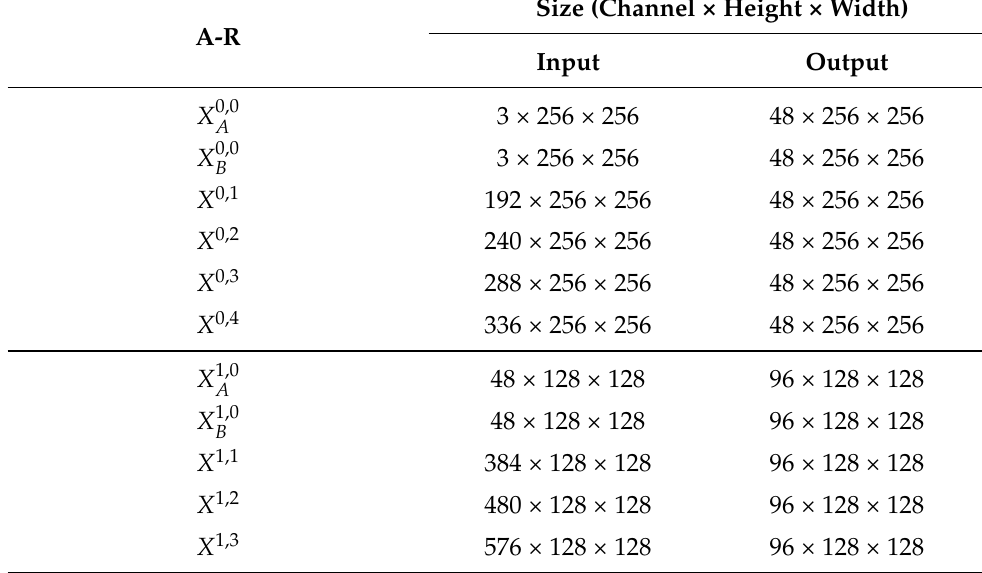
Table 1. Input and output size of the backbone